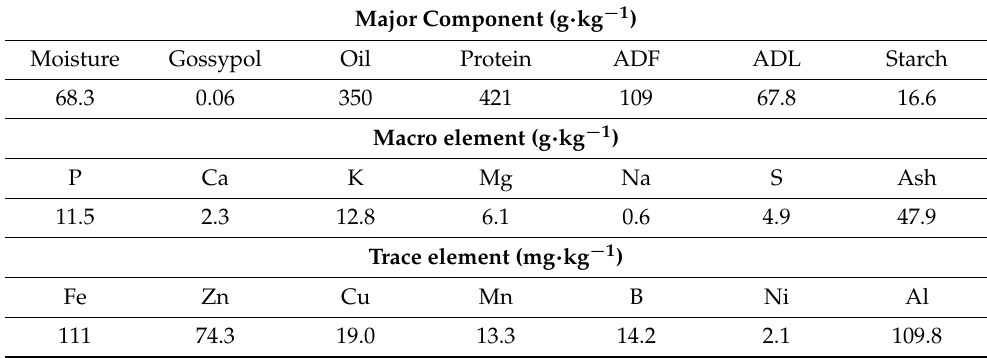
Table 1. Selected chemical components of glandless cottonseed kernels. ADF, acid detergent fiber. ADL, acid detergent lignin. Adapted from